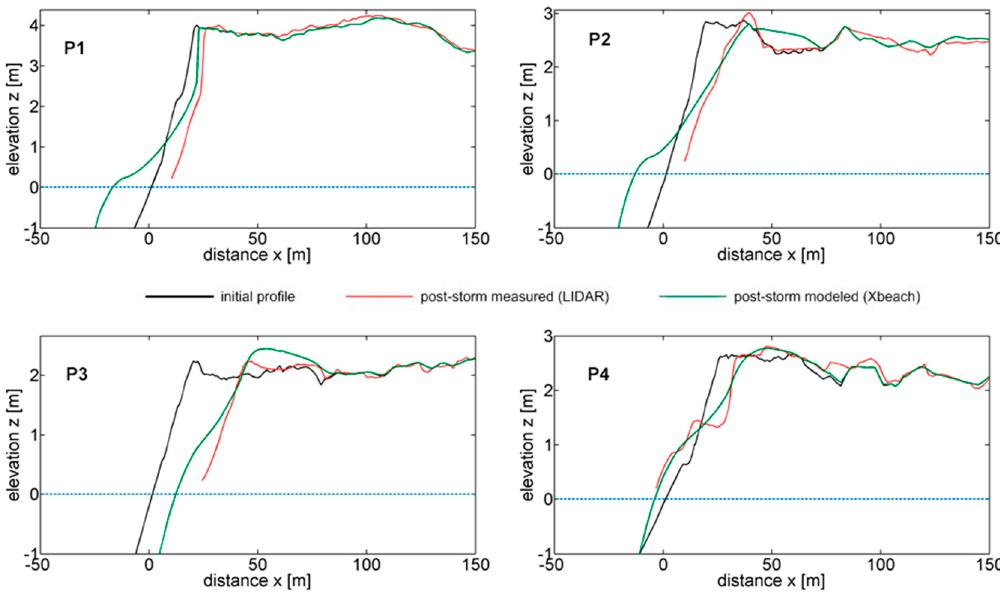
Figure 6. Comparison between XBeach simulated and measured beach profiles after the impact of the storm (see profiles location in Figure 5).